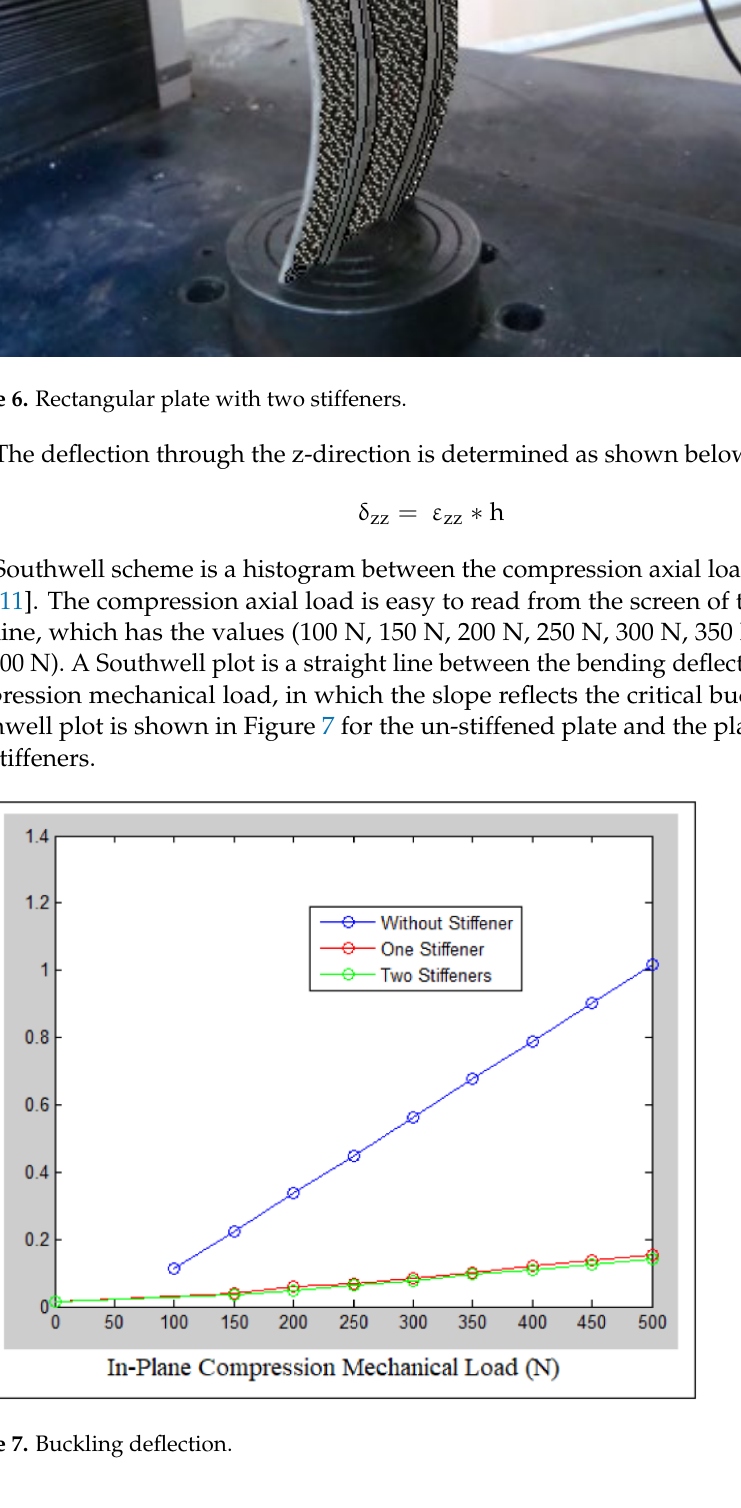
Figure 5. Rectangular plate with one stiffener.